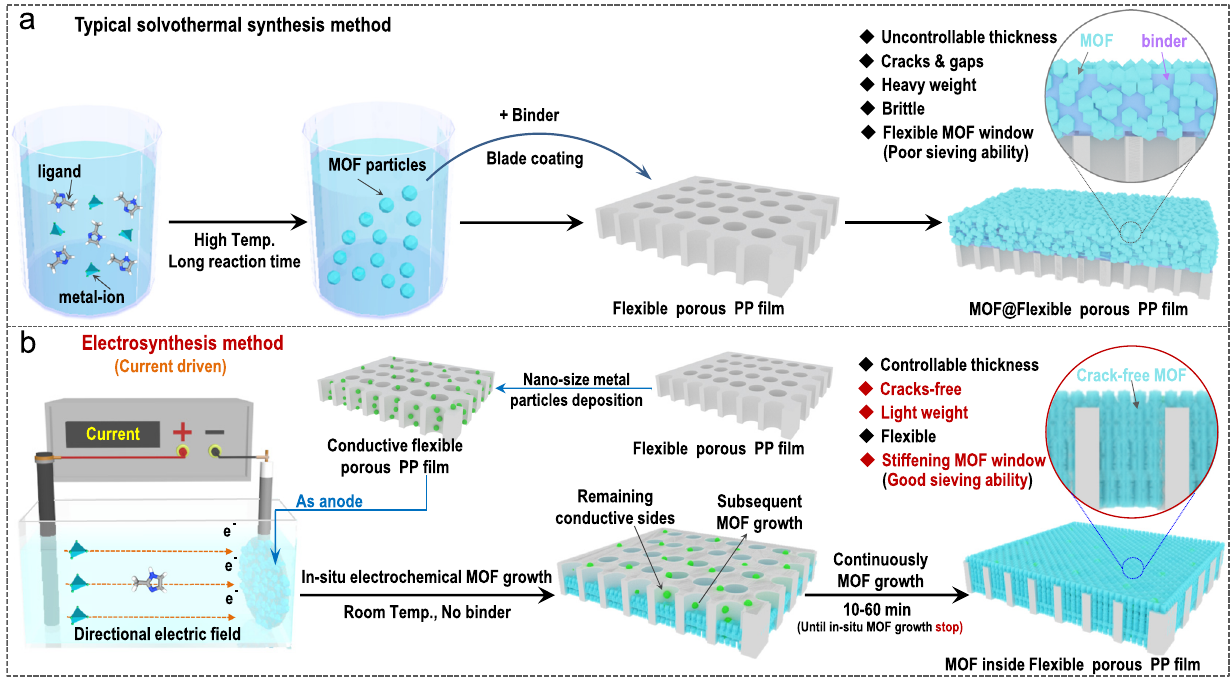
Fig. 2 | Schematic of the crack-free improved ultrathin MOF-based separator prepared with the current-driven electrosynthetic method. a Schematic representation of the typical method for preparing a MOF coated on a fl exible porous polypropylene fi lm (PP) by directly blade coating MOF particles prepared through a conventional solvothermal synthetic method and the corresponding